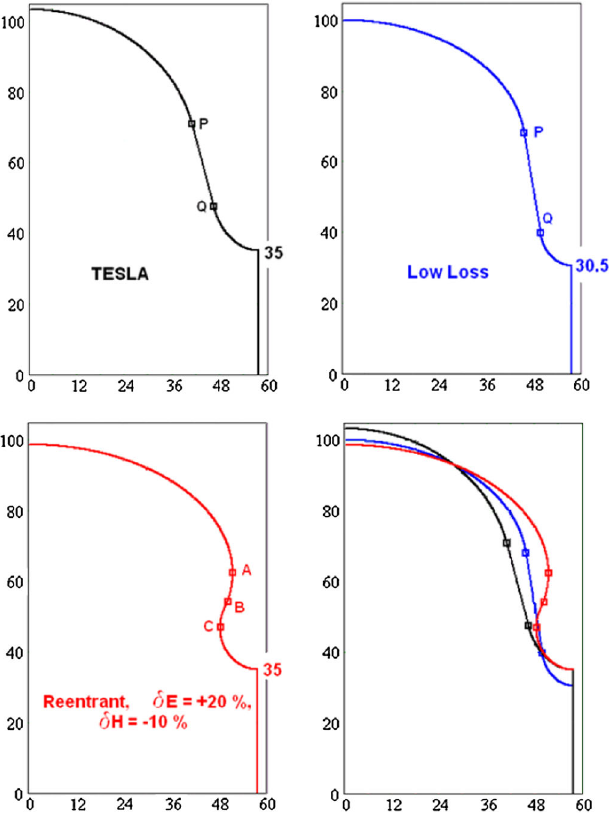
FIG. 3. Comparison of three known geometries of the elliptic half-cells.